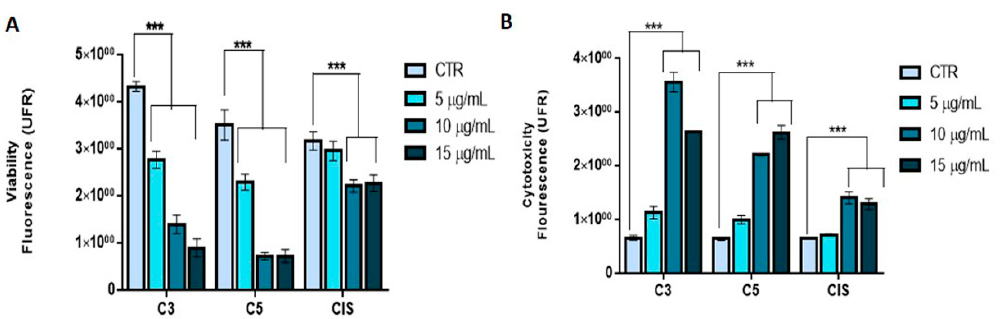
Figure 1. Cytotoxicity in SiHa cells. ( A ) Cell viability measured after 24 h of exposure in SiHa cells. ( B ) Cell cytotoxicity measured after 24 h of exposure in SiHa cells. There was an increase in cytotoxicity and a decrease in viability in a dose-dependent manner ( p < 0.0001). C3: Ethyl acetate fraction; C5: Fraction enriched in acetogenin; Cis: cisplatin. *** Indicates a statistical difference between groups. UFR: Relative unit of fluorescence.